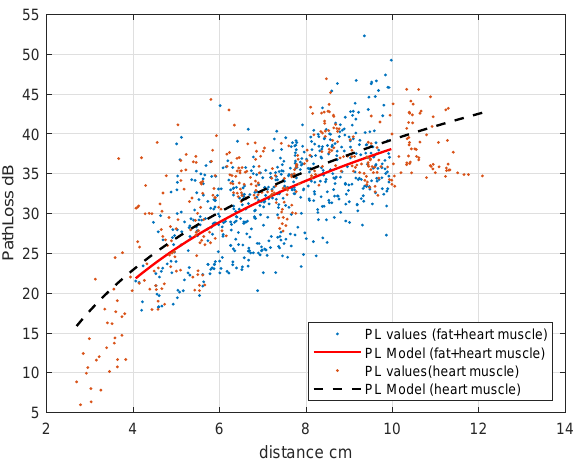
Figure 11. Path-loss legitimate link (IB2IB,